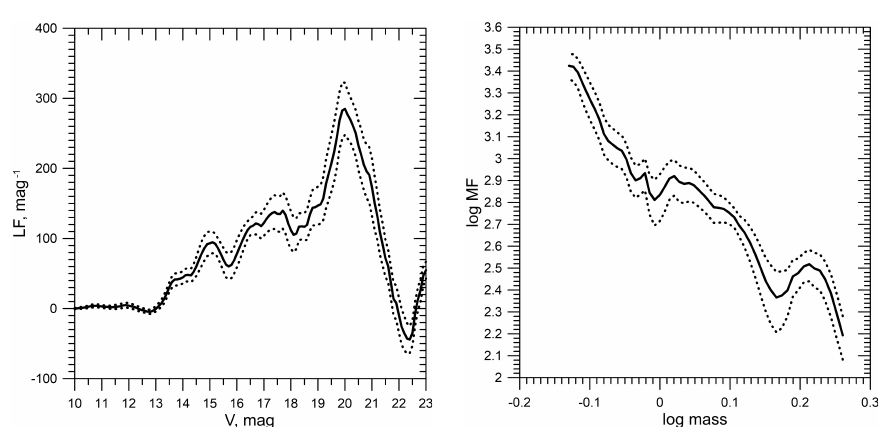
Fig. 3. Left-hand panel : the luminosity function of the open cluster NGC 4337. The solid line shows the difference between the kernel estimates for the cluster field and the control field; the dotted lines show the confidence interval. Right-hand panel : the mass function of NGC